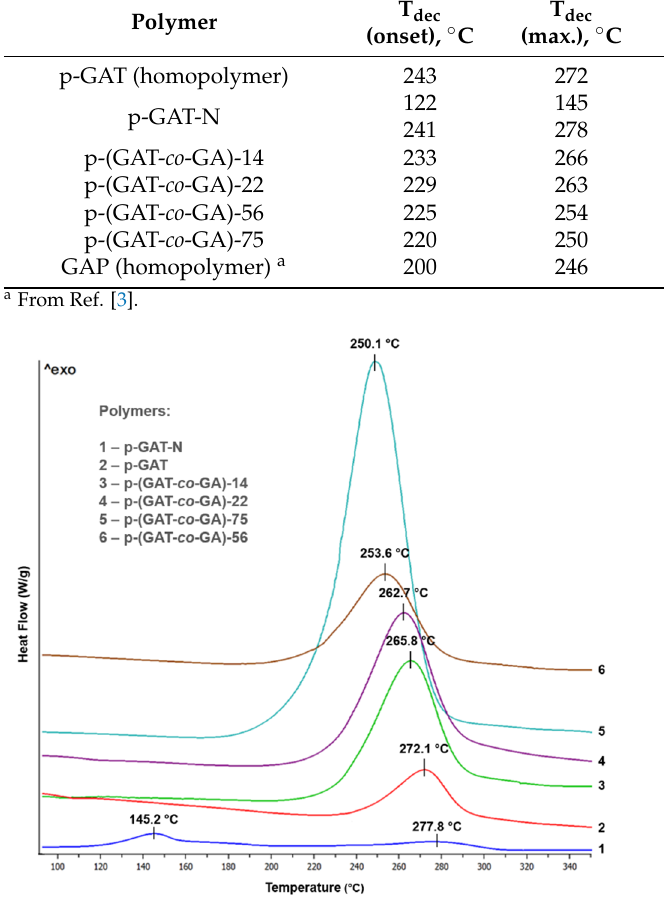
Figure 4. A DSC image of the p ‐ GAT and p ‐ GAT ‐ N polymers and of p ‐ (GTO ‐ co ‐ GA) copolymers.